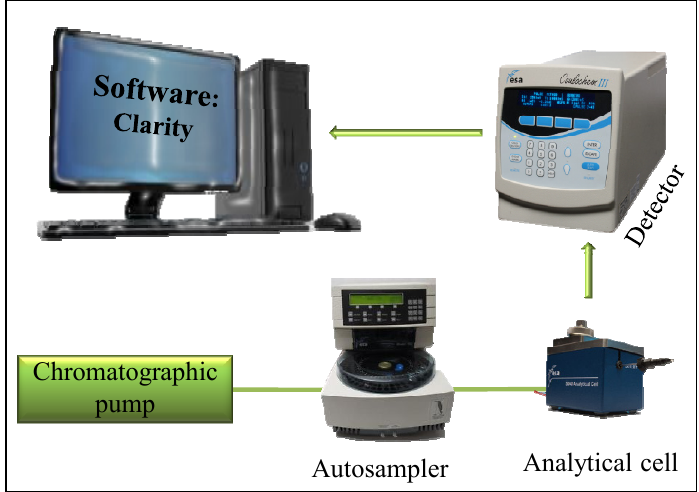
Figure 1. Scheme of FIA-ED system used for determination of platinum-based cytostatics and platinum